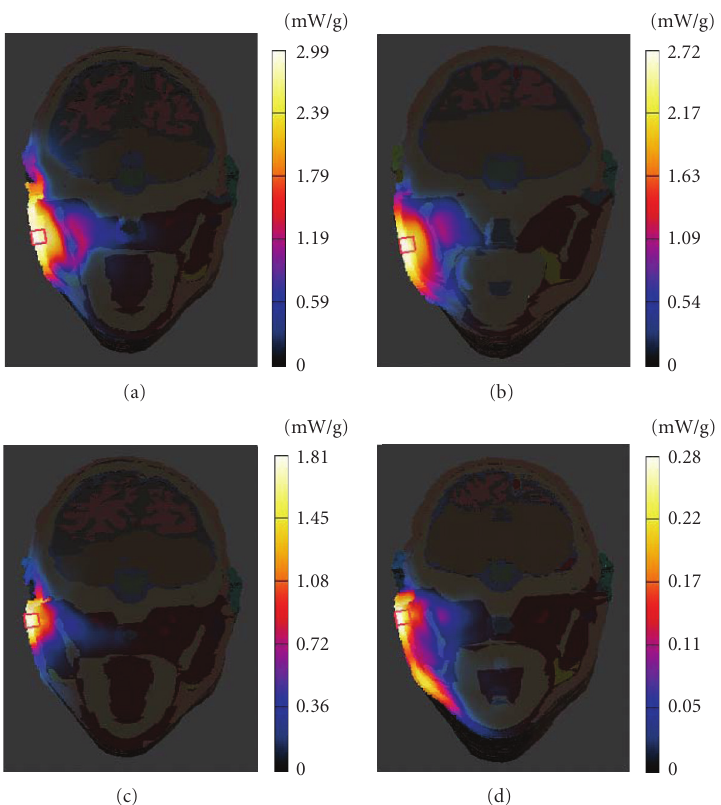
Figure 9: Sliced-distribution of the averaged peak SAR 1g in the yz -plane of the HR-EFH phantom in cases of handset models at cheek position. The antenna input powers are 0.6 W and 0.125 W for the frequencies 900 MHz and 1800 MHz, respectively. (a) Model no. 1 at 900 MHz, (b) Model no. 2 at 900 MHz, (c) Model no. 1 at 1800 MHz, (d) Model no. 2 at 1800 MHz. Table 6: The computed averaged peak-SAR (over 1g and 10g) and power absorption in tissues, radiated power, total loss, total isotropic sensitivity, and computation error for both handset models in hand close to head at di ff erent positions and at 1800MHz. 1800 MHz- Cheek 1800 MHz- Tilt SAM HR-EFH (Adult) SAM HR-EFH (Adult) Handset